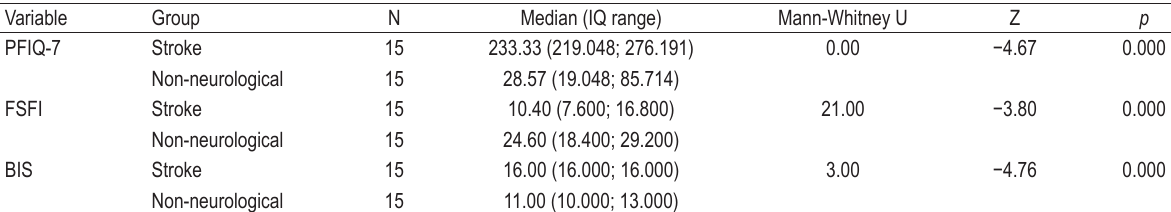
TABLE 3. Mann–Whitney test between